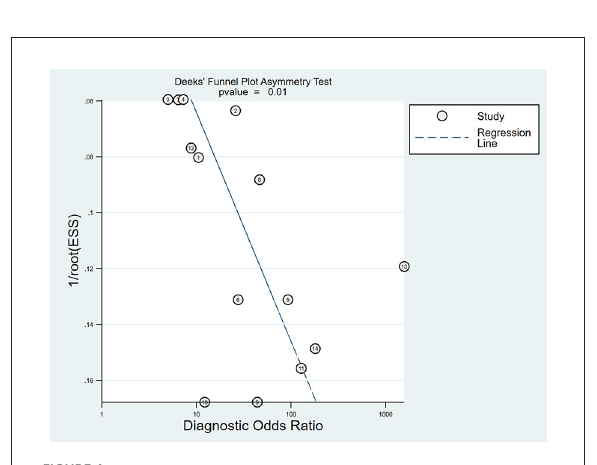
FIGURE4 Deeks’ funnel plot used to assess publication